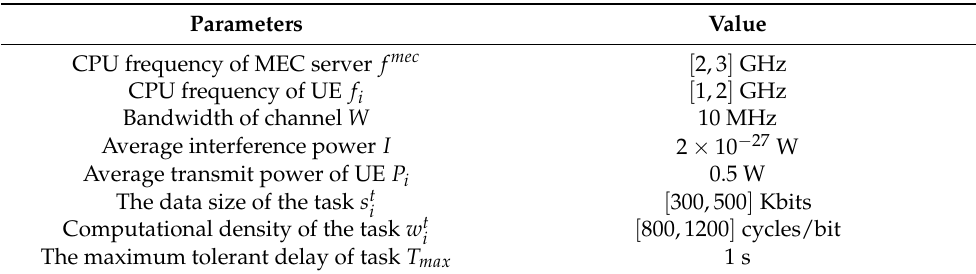
Table 2. Simulation parameter settings.